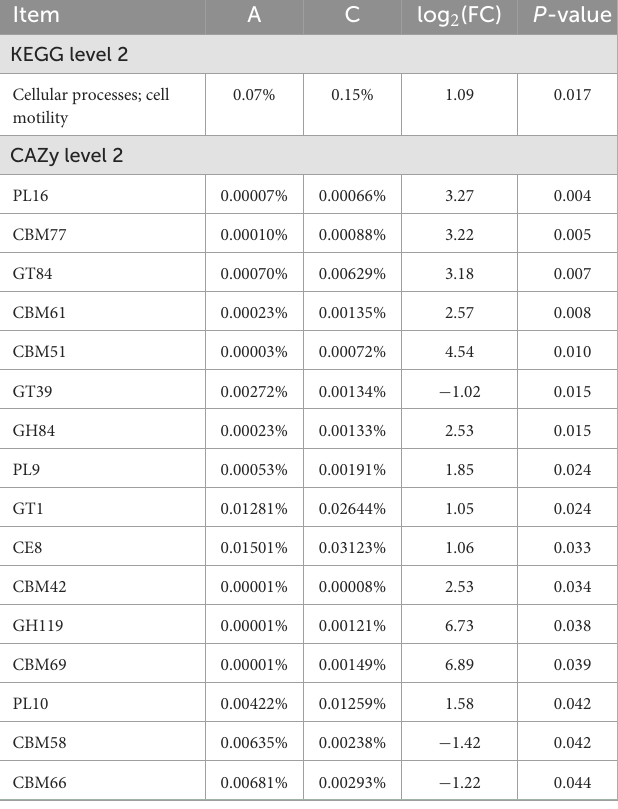
TABLE 4 Different functions of rumen microbiota at level 1 or level 2 based on KEGG and CAZy database.